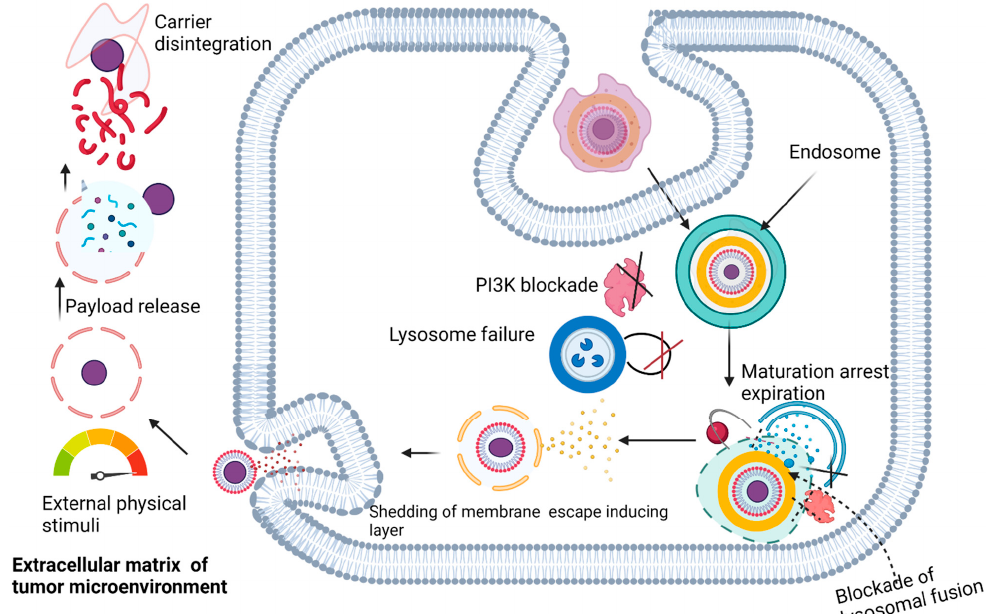
Figure 6. Mechanism of drug release from synthetic microbe. The microbe undergoes endocytosis but is not degraded due to the presence of effectors that block the attachment of PIK3 and lysosomes. Upon expiration of the macrophage maturation arrest, the macrophage degrades the membrane escape-inducing layer (effectors), thereby releasing the drug-containing nanoparticles, which expel the drug upon application of an external physical stimuli at the tumor site. Modified from Ref [114].